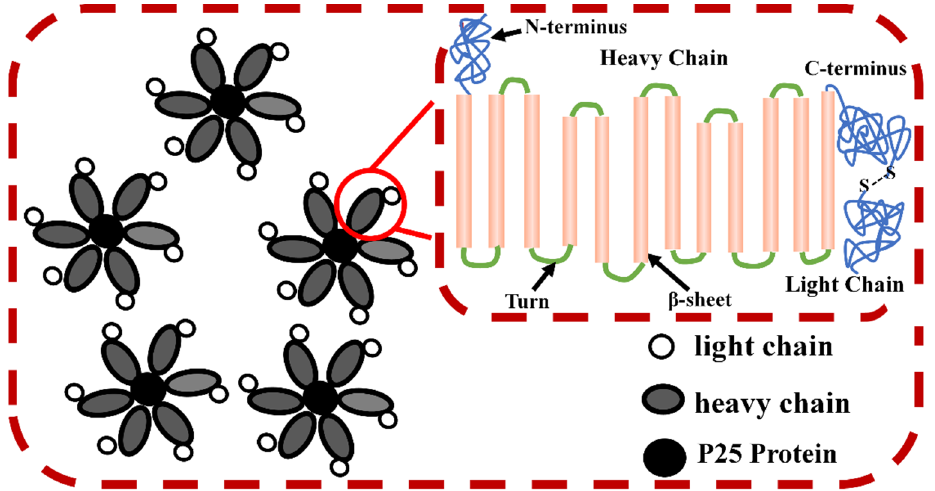
Figure 2. Schematic diagram of the secondary structure of complexation of P25 protein with H chain and L chain in SF. Reproduced with permission from [42], Copyright (2022) Elsevier.